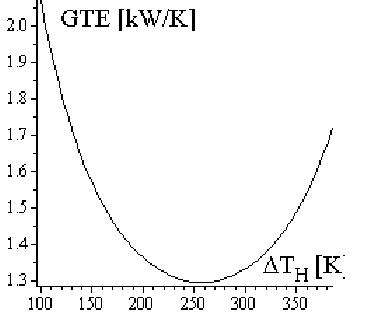
Figure 21. G TR dependence of ∆ T R —case “d”. G TRmin = 2.574 for ∆ T R = 7.77